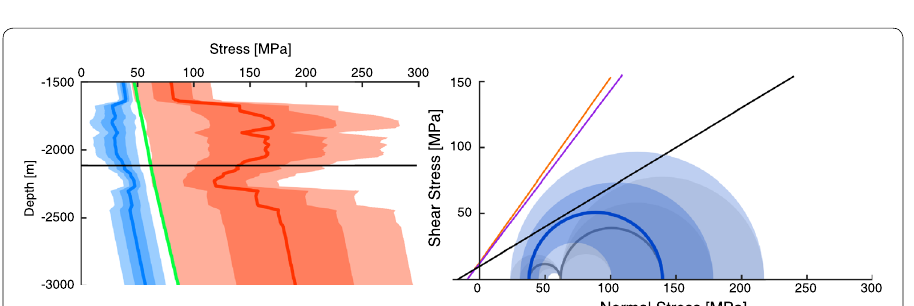
Fig. 10 Modelled stress state at the geothermal project Aschheim/Feldkirchen/Kirchheim where no seismicity has been recorded yet. The target depth at horizontal line. For a detailed explanation refer to Fig.